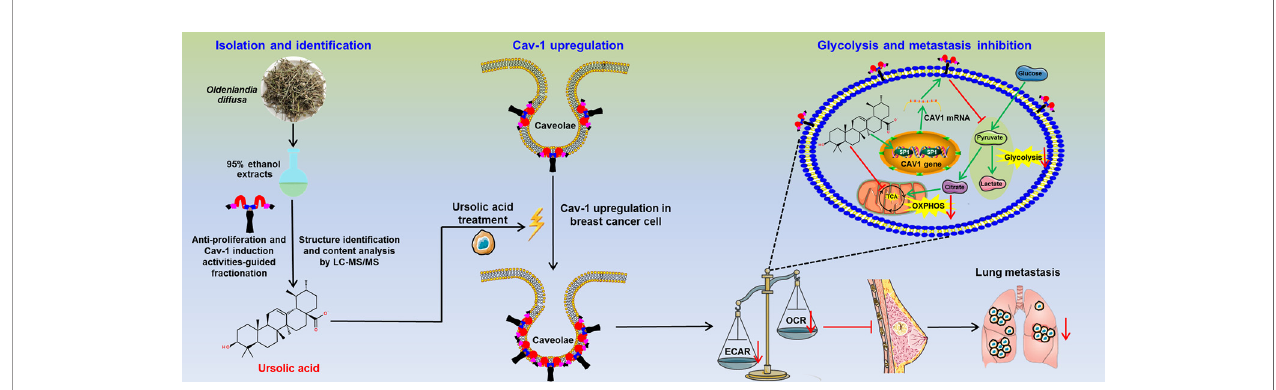
FIGURE 7 | The schematic diagram of this study. Ursolic acid is identi fi ed as the bioactive compound of Oldenlandia diffusa against breast cancer. Ursolic acid inhibits breast cancer metastasis by suppressing glycolytic metabolism via activating SP1/Caveolin-1